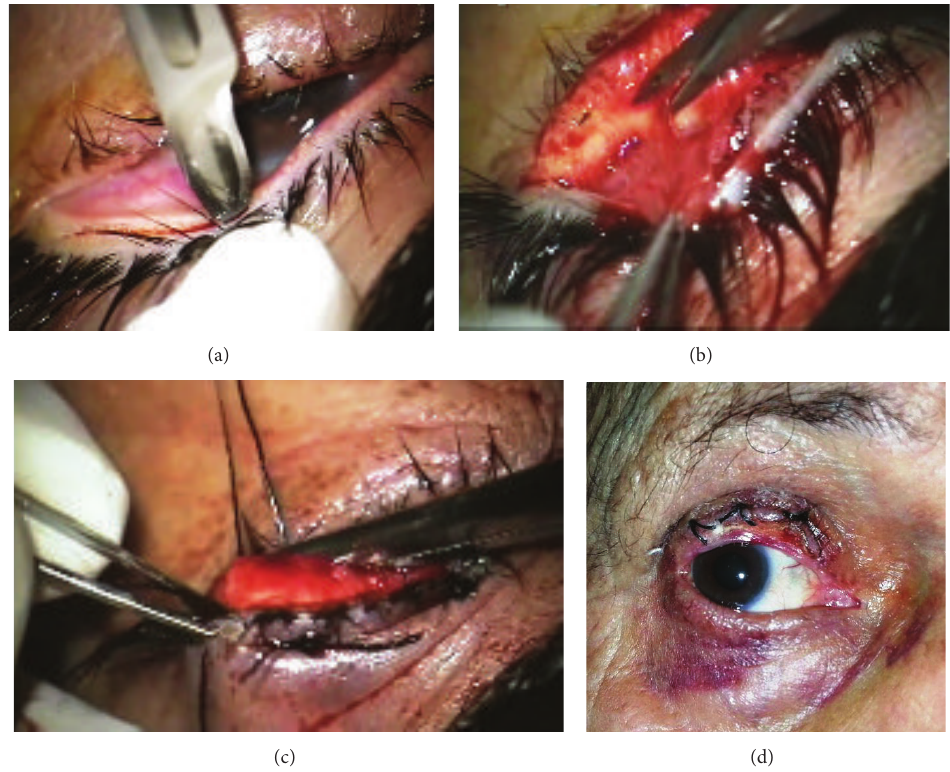
Figure 1: Anterior lamellar reposition in the upper lid: (a) Making the incision behind the abnormal lash line. (b) Separation of the anterior lamella. (c) The anterior lamella is recessed and fixated by 3 sutures. (d) 2wks. after operation; the granulation tissue is formed, covering the posterior lamella.